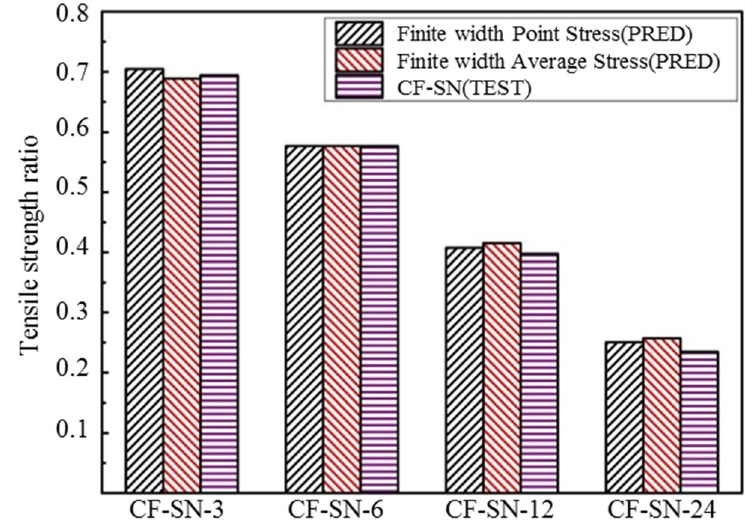
Figure 26. Comparison of the tensile strength of the equal specimen size group predicted by the point stress criterion and average stress criterion in the finite-width stress criterion with test results; compared with the WN stress criterion, the predicted value of the new formula is closer to the real experimental values, especially when the notch size is large ( W /2 C ≤ 6 ).